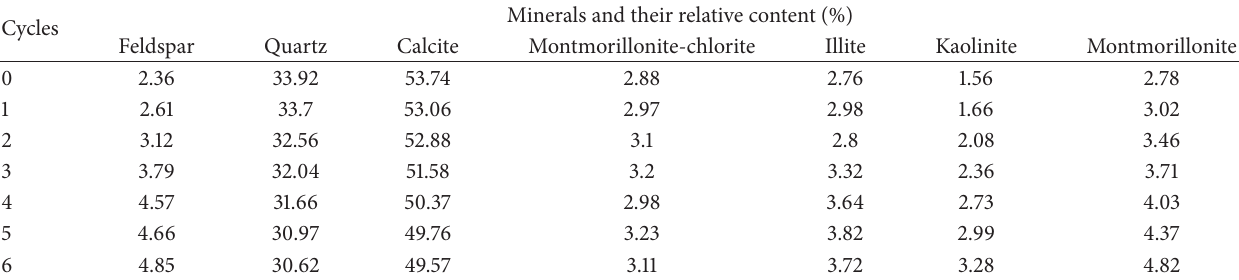
(b) Variations in the four kinds of clay minerals Figure 11: Variation in mineral content under the wet-dry cycle. Table 3: Results of the XRD tests under different wet-dry